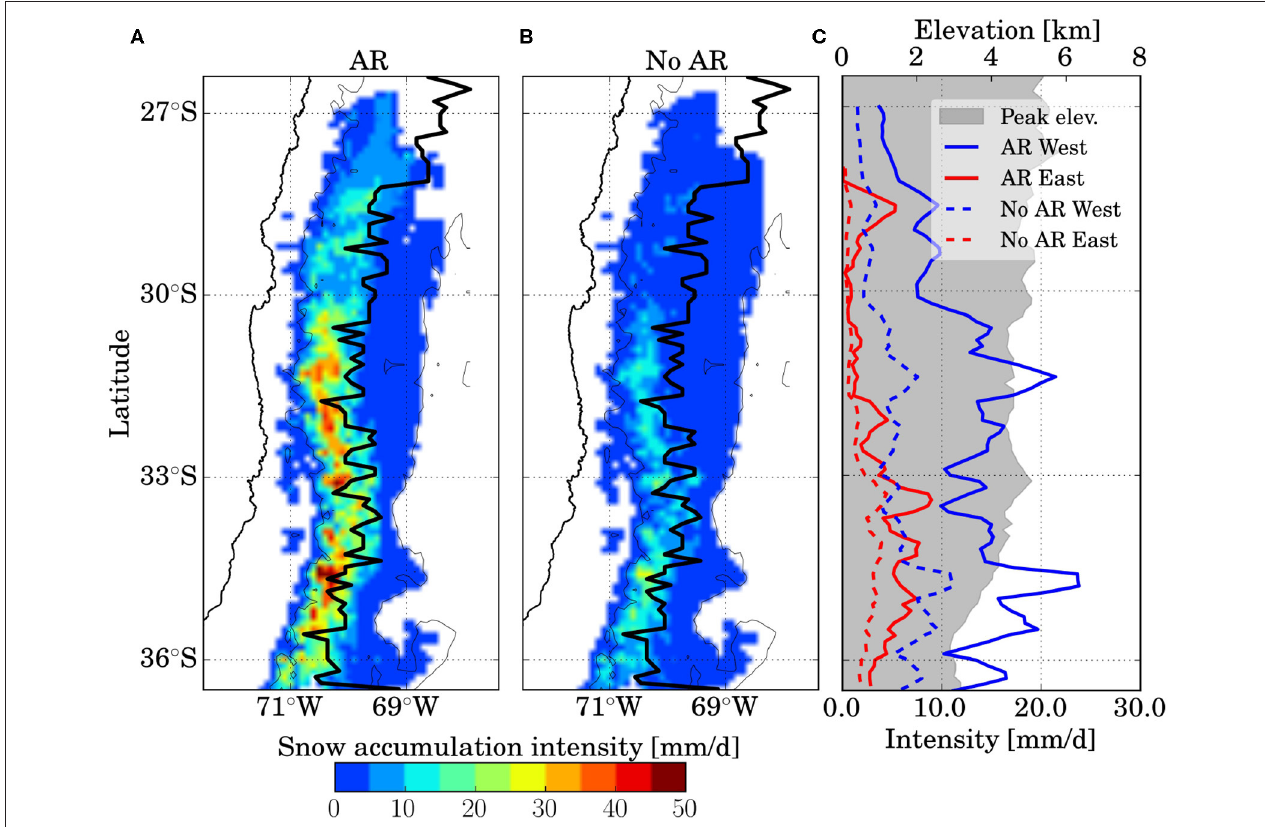
FIGURE 4 | Mean daily snowfall intensity for (A) the AR and (B) the non-AR snowfall events on pixel scales. The crest of the Andes and the 2,000 m topographic line are plotted by thick and thin black lines, respectively. (C) Variations with latitude of the altitude of the crestline (shaded in gray) and of the mean daily snowfall intensity on the western (blue lines) and eastern (red lines) slopes for the AR (continuous lines) and non-AR (dashed lines) snowfall